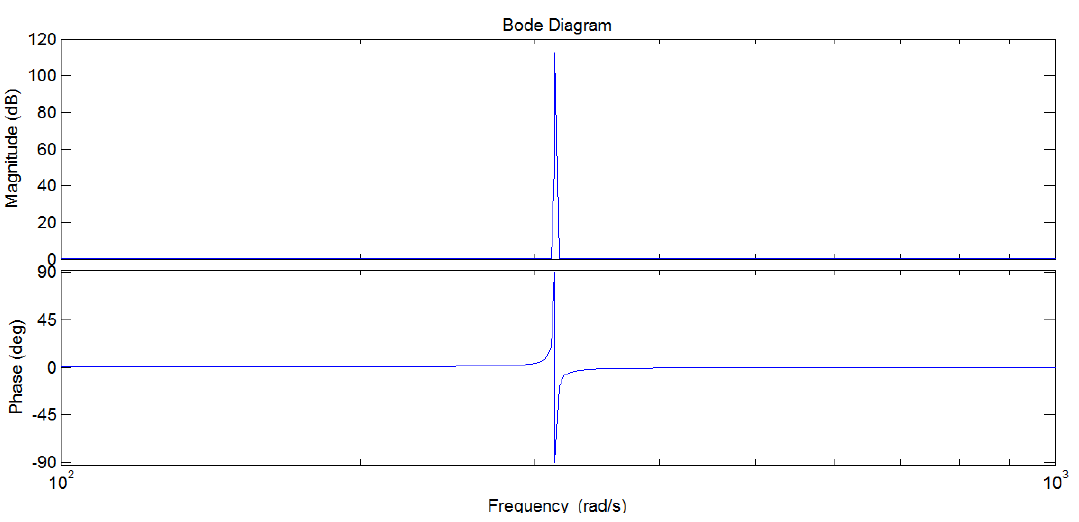
Figure 3. Bode diagram of ideal proportional-resonant (PR)